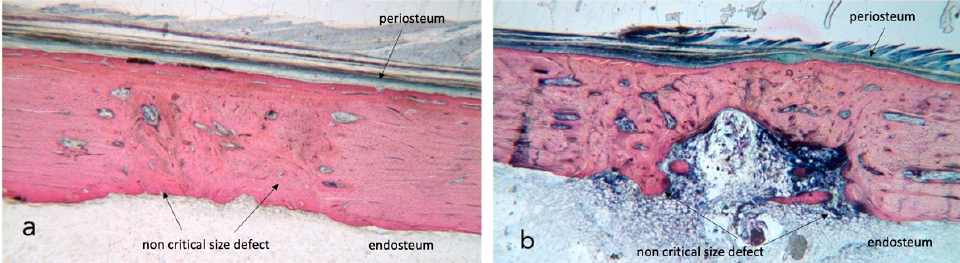
Figure 1. Stevenel’s blue/van Gieson’s picrofuchsin stained samples for light microscope analysis. ( a ) shows a control section with dense bone approaching 100% regeneration while in section ( b ) native tibia presents heavy damage by radiation and bone fill is incomplete. The external cortical is closed and covered by a continuous periosteum; the inner endosteal side presents a bone marrow ingrowth with signs of inflammation. ×2.5 magnification.